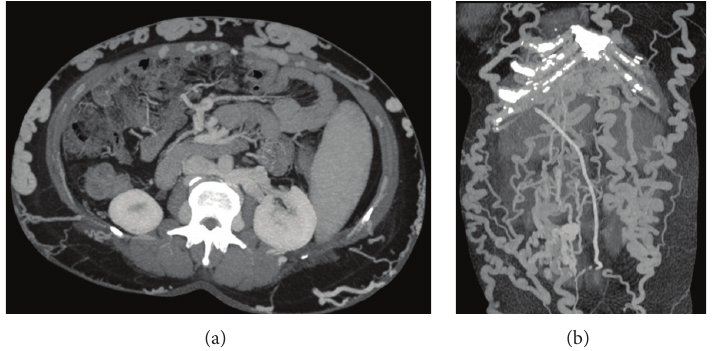
Figure 29: Axial (a) and coronal (b) MIP images showing multiple abdominal wall collaterals in a patient with IVC thrombus.